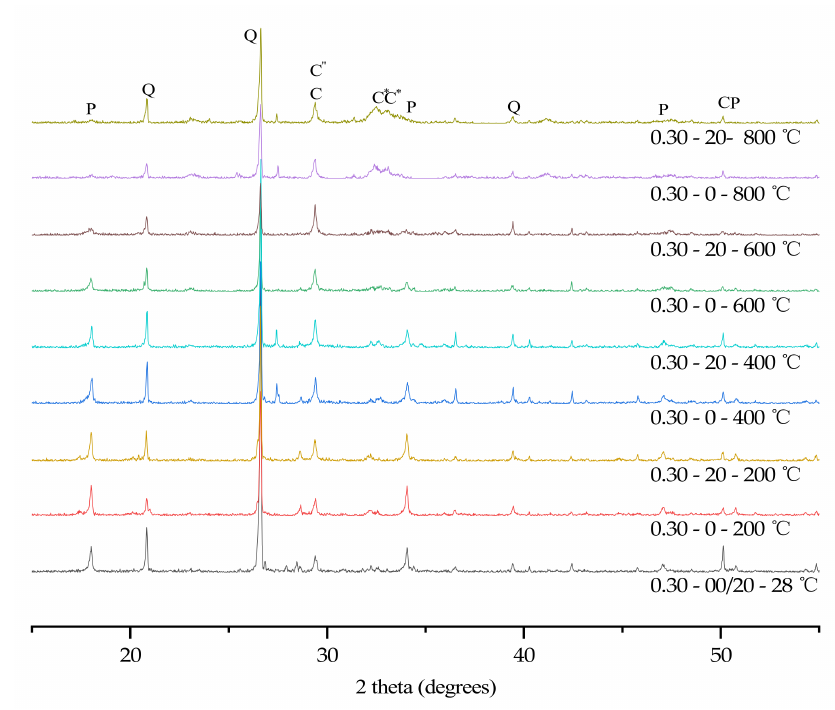
Figure 4. X-ray diffractograms of concrete (W/C = 0.30). Keys to phases: P (Portlandite); Q (Quartz); C (C-S-H gel); C” (Calcite); C* (Calcium